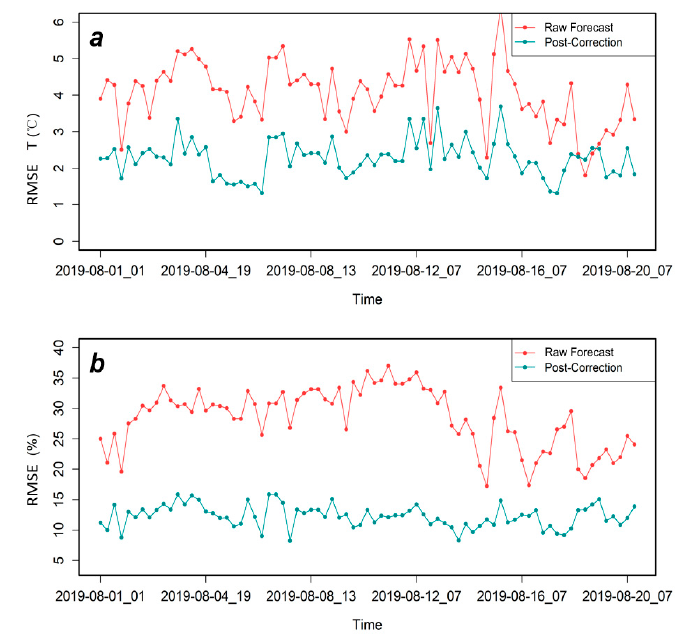
Figure 14. RMSE of raw forecast and post-correction results in each forecast period for: ( a ) temperature and ( b ) relative humidity at station 51359.